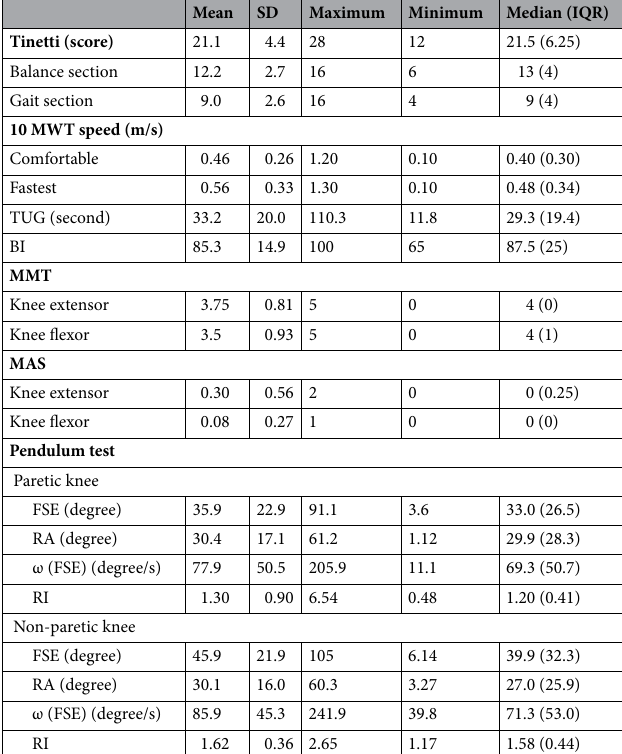
Table 3 shows the result of Spearman correlation test. The Brünnstrom stage correlated with all functional indexes, including the total, balance and gait scores of TT, comfortable and the fastest speeds of 10 MWT, time of TUG, as well as Barthel index (BI). The MMT of paretic knee extensor correlated with all function assessment except for the comfortable speed of 10-MWT. The MMT of hip flexor and extensor significantly correlated with the gait com- ponent and total score of TT (Supplementary table 1). The MMT of ankle extensor correlated with both gait component of TT, walking speeds, time of TUG and BI (Supplementary table 1). For paretic knee extensors, the MAS negatively correlated with the total (r = −0.313, p <0.01) and gait scores of TT (r = −0.433, p <0.01). The FSE positively correlated with the balance score of the TT (r =0.443, p <0.01). RI was separately correlated with both comfortable (r = 0.427, p <0.01) and the fastest speeds (r=0.327, p < 0.05) of 10-MWT. For each function scale, the tolerance of Brünnstrom stage, FSE, RI and MMT and MAS of knee extensor, were all larger than 0.5 with VIF < 2 in the collinearity test. Partial correlations between MMT, MAS, pendulum test and functional mobility. Table 4 shows the result of partial correlation test. After controlling the factor of motor recovery (Brünnstrom stage), the MAS of paretic knee extensor stood negative correlation to the gait score of the TT (r = −0.355, p =0.027). The FSE positively correlated with the balance score of TT (r =0.318, p =0.018), but negatively correlation to the comfortable speed of 10-MWT (r = −0.322, p =0.046). The RI positively correlated with the comfortable speed of 10-MWT (r =0.367, p =0.022). The correlations between mobility performance and the MMT of hip and ankle segments were insignificant (Supplementary table 1).